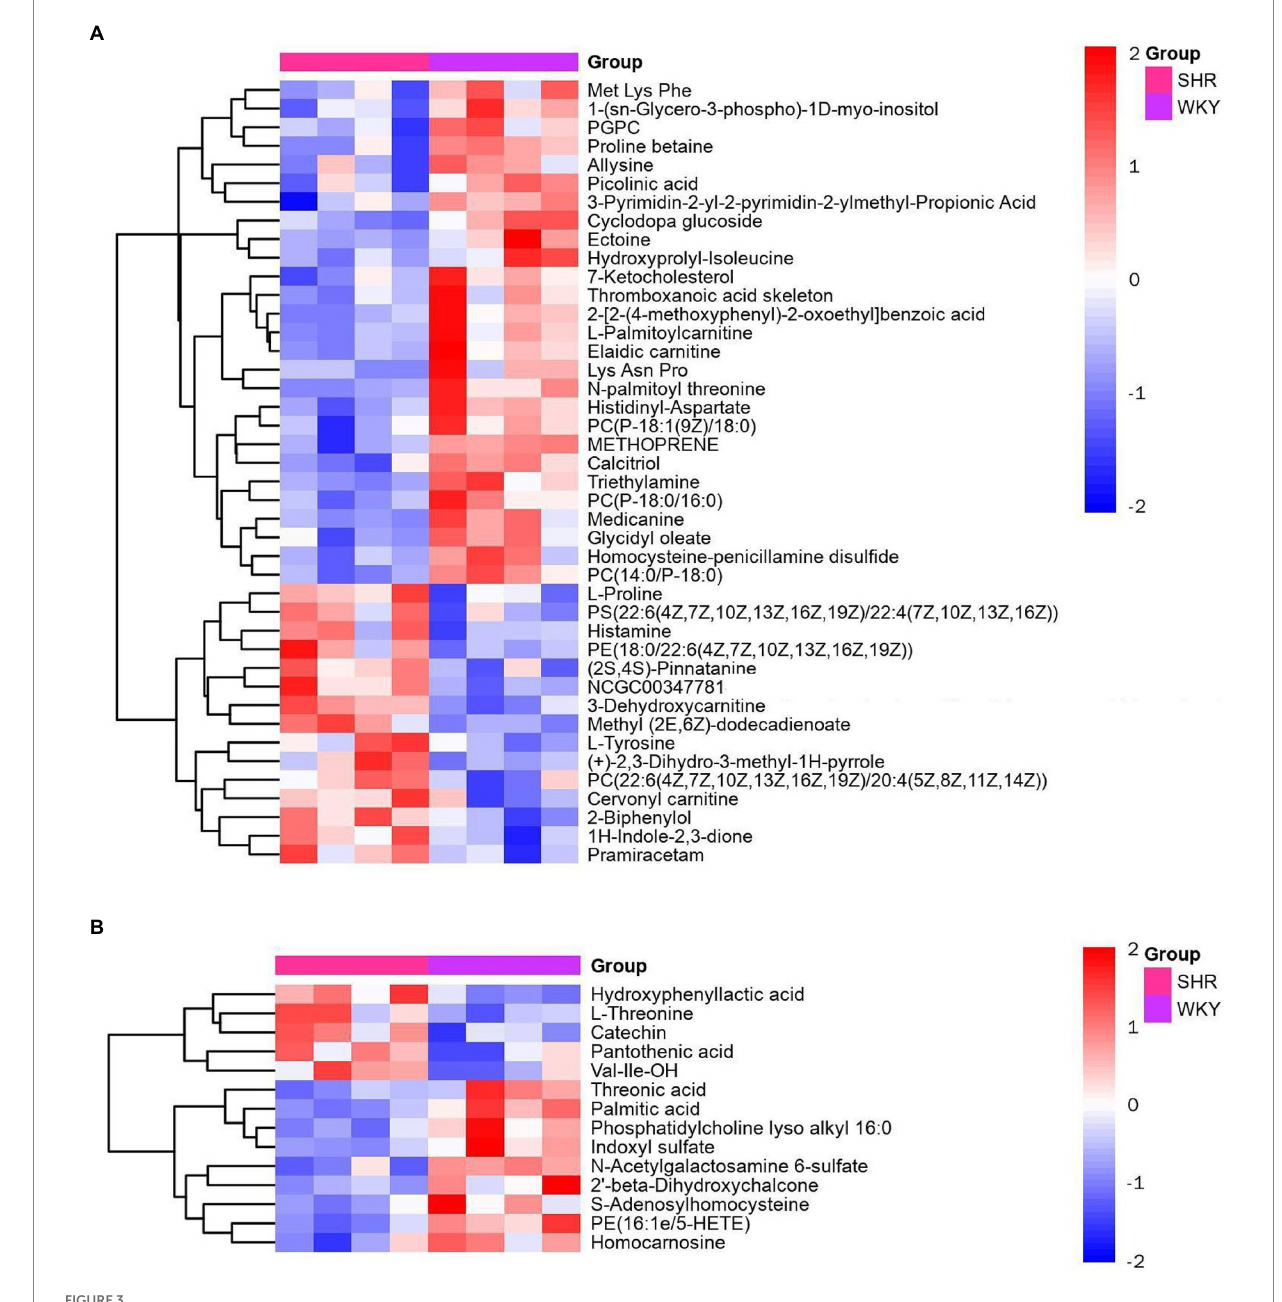
FIGURE 3 Heatmap of hierarchical clustering analysis for the SHR and WKY groups ( A : positive ion mode. B : negative ion